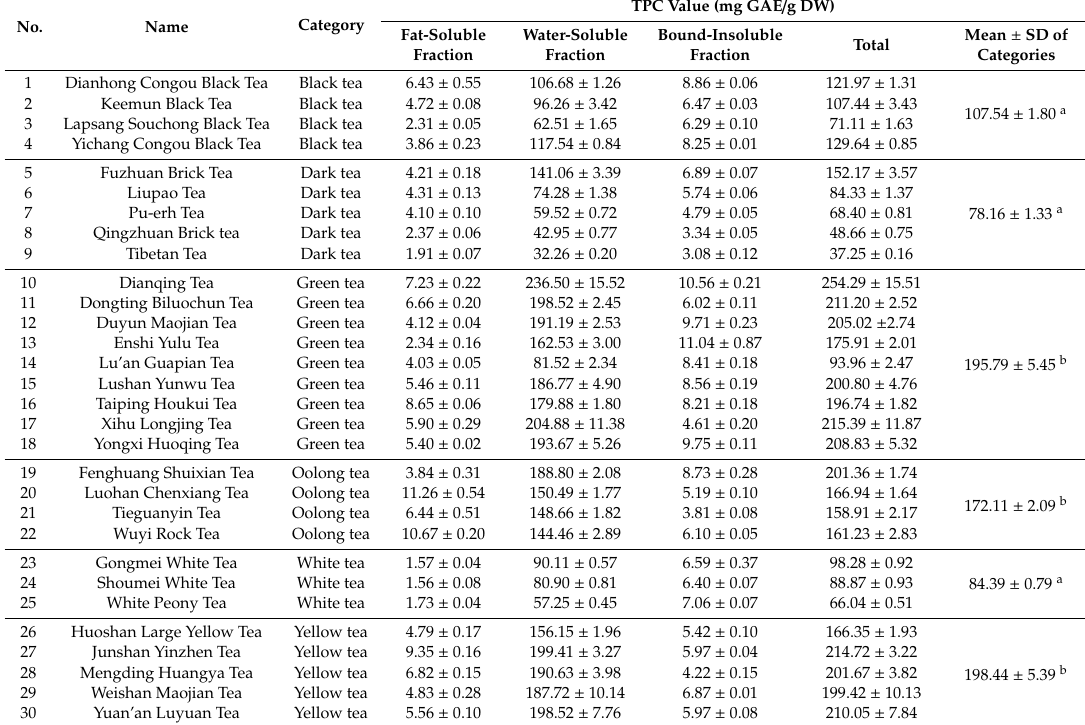
Table 5. Total phenolic content (TPC) values of the 30 common Chinese teas.